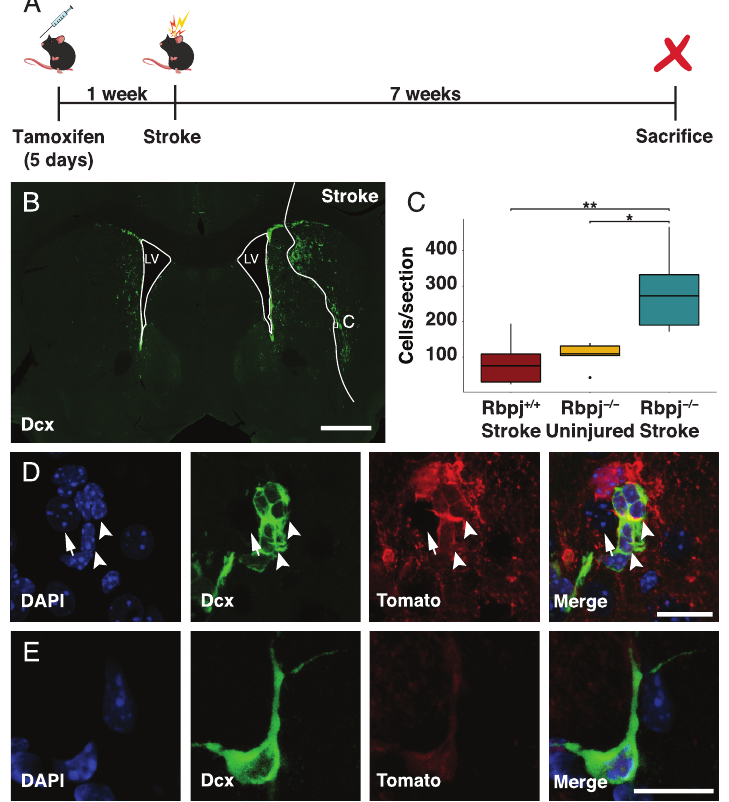
Figure 1. An increased number of neuroblasts is generated after stroke by blocking Notch-signaling. Analysis of Dcx expressing cells in the brain of mice with selective ablation of Rbpj in astrocytes after stroke: ( A ) Summary of the experimental procedure—mice were administered tamoxifen via intraperitoneal injection for five consecutive days. One week after the last injection, stroke was induced, and the animals were then sacrificed seven weeks later; ( B ) Overview of Dcx + cells in the injured and uninjured hemisphere seven weeks after stroke (scalebar = 500 µ m); ( C ) Quantification of the number of Dcx + / Tomato + cells. For each animal, four sections around the core of the lesion have been selected and quantified. The average number of cells has been compared between the injured and the uninjured hemisphere from the same animals ( p = 0.041) and with the injured hemisphere of wild-type mice ( p = 0.005). Data were analyzed using a paired t-test, and results are presented as mean ± SD; ( D , E ) Close-up of clusters; ( D ) Single close-up; ( E ) Dcx + / Tomato + cells found in the penumbra of the stroke area. Arrowheads indicate cells that are positive for both Dcx and Tomato, while the arrow points at a Tomato + cell (scalebar = 15 µ m and 6 µ m respectively in D and E